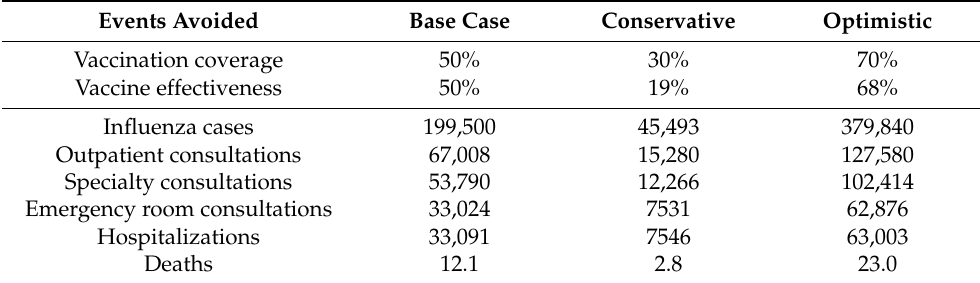
Table 11. Estimated influenza-related events avoided by immunizing the population aged 50 to 59 years: Sensitivity